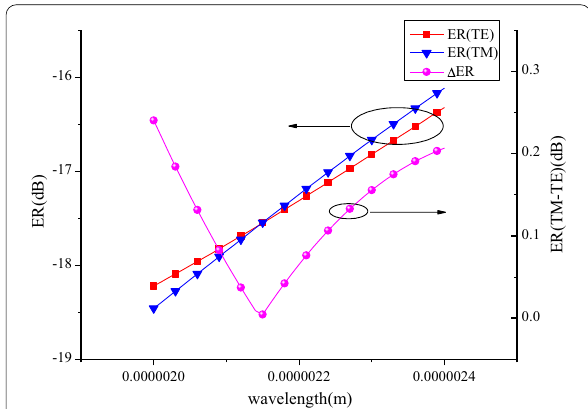
Fig. 7 Modulation depth of the two modes and PSL (line ER(TE-TM)) between two modes at different